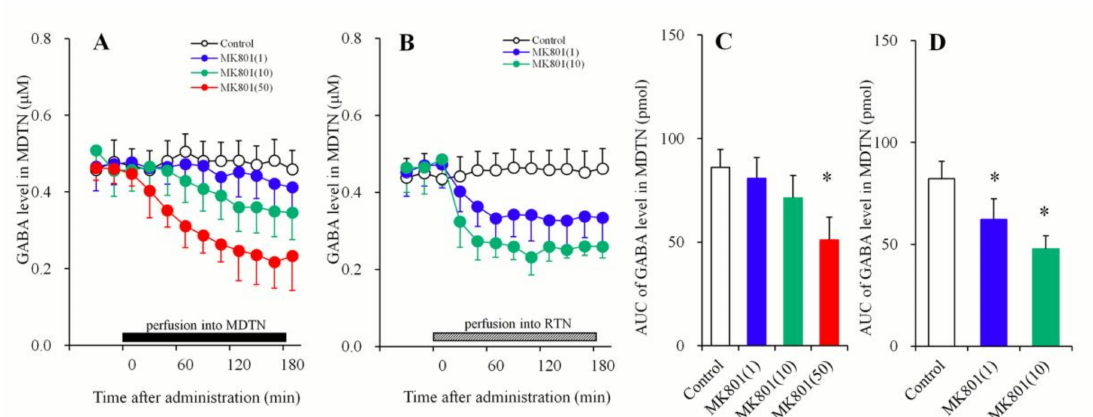
Figure 2. Concentration-dependent e ff ects of local administration (perfusion) of MK801 into the MDTN ( A , C ) and RTN ( B , D ) on extracellular GABA levels in the MDTN. The perfusion medium commenced with MRS. After the confirming the stabilization of extracellular GABA levels in the MDTN, the perfusate in the MDTN (A: black column) and RTN (B: stripped column) was switched to MRS containing MK801 (1, 10, or 50 µ M) for 180 min. Ordinates: mean ± SD ( n = 6) of extracellular GABA levels ( µ M). Abscissa: time after administration of MK801 perfusion (min). AUC values of GABA levels (pmol) during perfusion with MK801 (from 20 to 180 min) based on ( A , B ) were indicated in ( C , D ), respectively. * p < 0.05. This is relative to the control (opened bar) using LME with Tukey’s post hoc